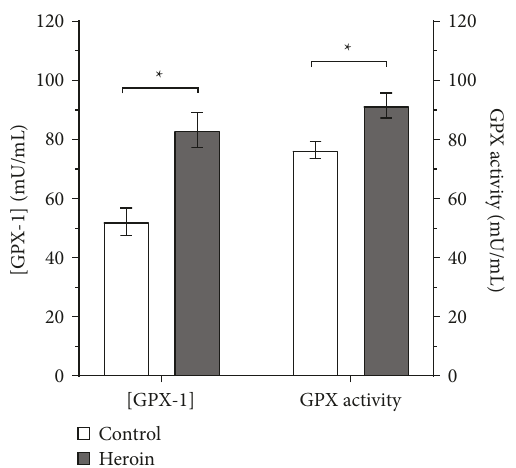
Figure 2: Comparative analysis of serum (a) glutathione peroxi- dase-1 (GPX-1) concentration and (b) glutathione peroxidase (GPX) activity between chronic heroin-addicted subjects and control subjects. Results are presented as mean ± SEM in milliunits per milliliter (mU/mL). ∗ indicates a significant comparative analysis with p � 0 . 001.